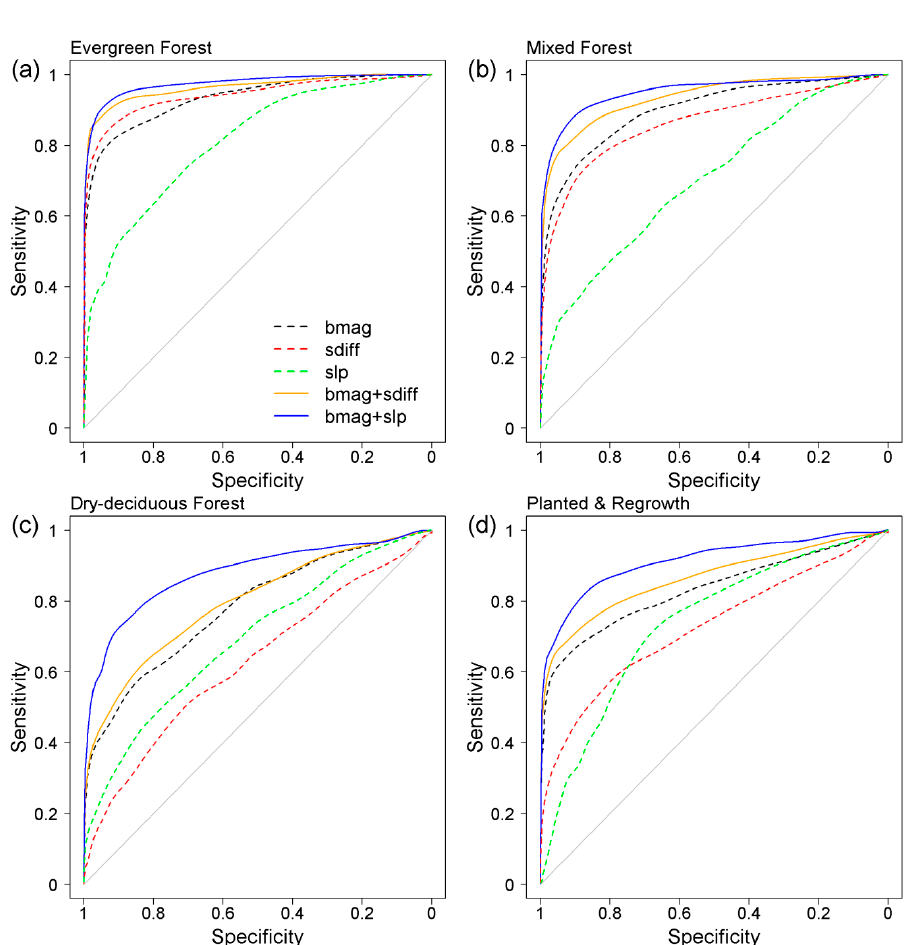
Figure 4. Receiver operating characteristic (ROC) curves for models using different explanatory variables and combinations of variables. Panels represent forest type: evergreen forest ( a ); mixed forest ( b ); dry-deciduous forest ( c ); and planter forest and regrowth ( d ). The variable combination bmag + sdiff + slp was omitted from the plots as it closely resembled the curve of bmag + slp . By plotting omission versus commission errors for each model, any point on each error curve corresponds to a specific model probability threshold (Figure 5). Using forest-type specific models,